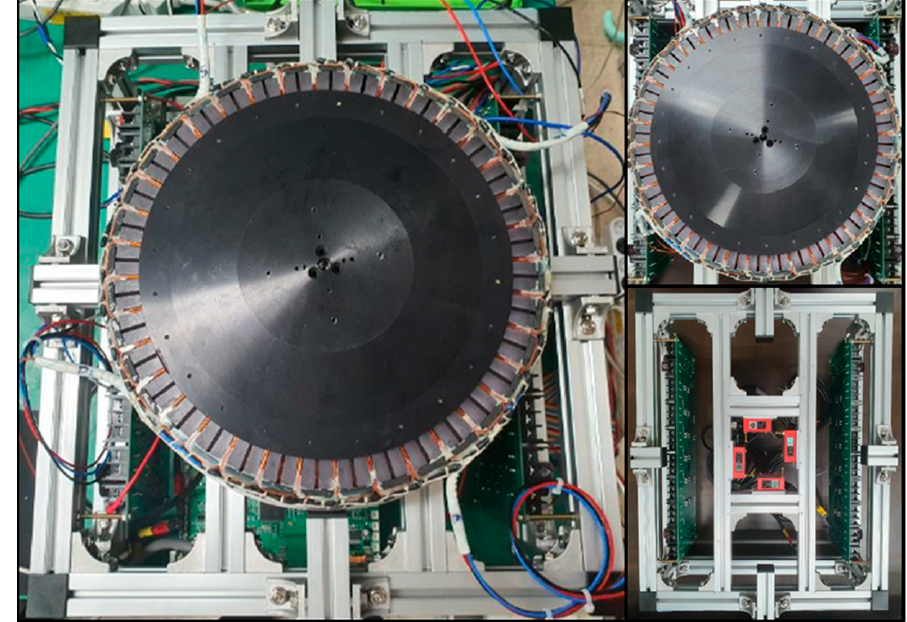
Figure 17. Prototype of 6-DOF magnetic levitation system.